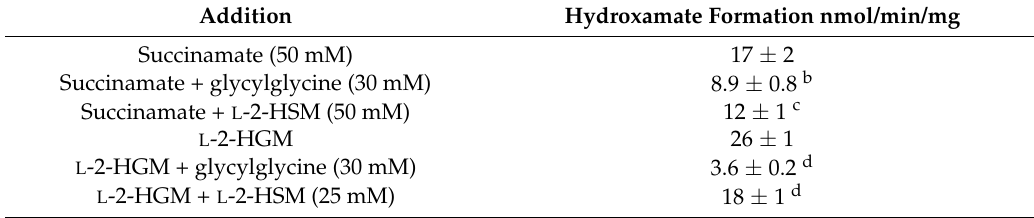
Table 2. Hydroxaminolysis of succinamate and L -2-Hydroxyglutaramate ( L -2-HGM) catalyzed by rat liver cytosol in the absence or presence of an inhibitor a . Addition Hydroxamate Formation nmol/min/mg Succinamate (50